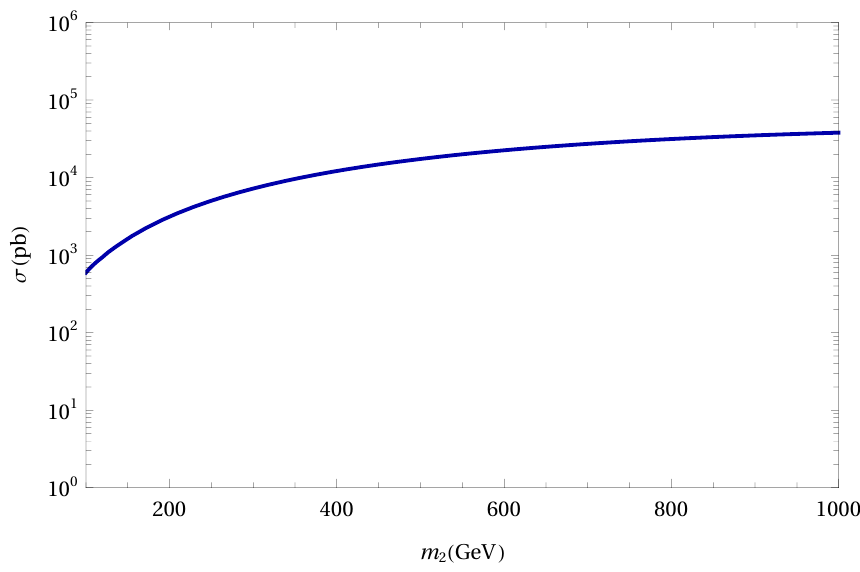
Figure 6 . The production cross section of ψ 2 as a function m 2 for the process pp → ψ 2 + X corresponding to the partonic process gg → ψ 2 at the LHC with and c G = 1